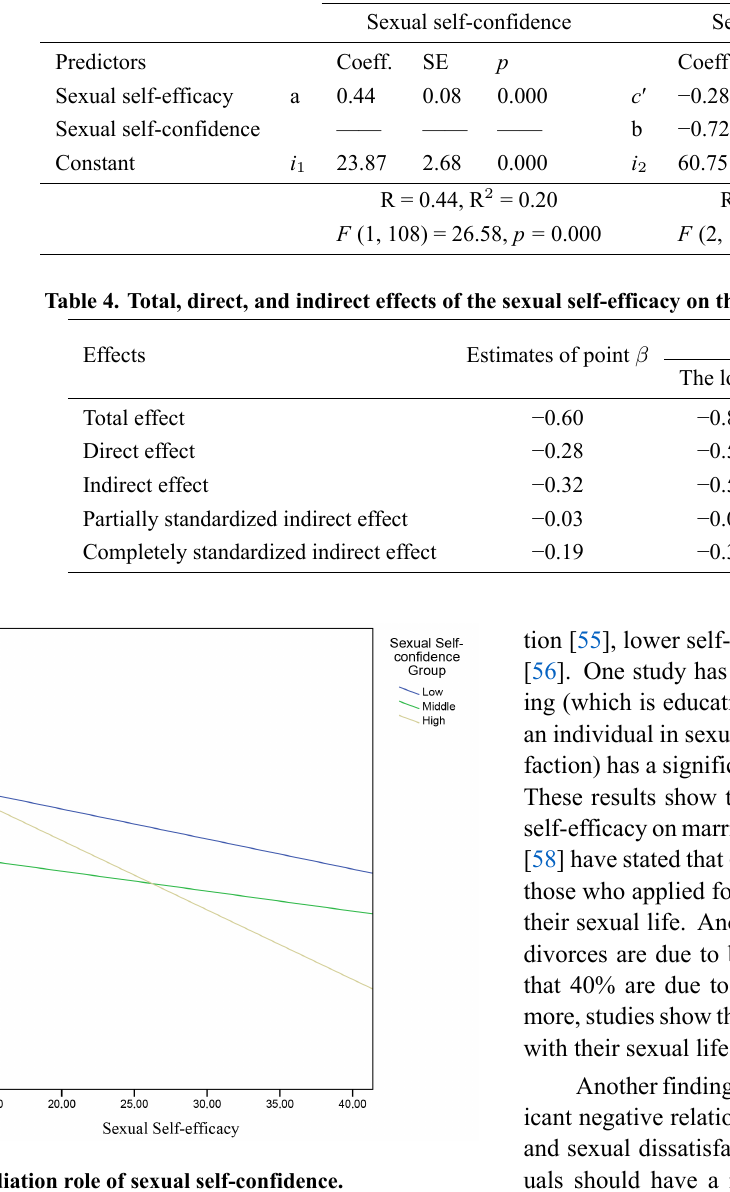
Fig. 1. Mediation role of sexual